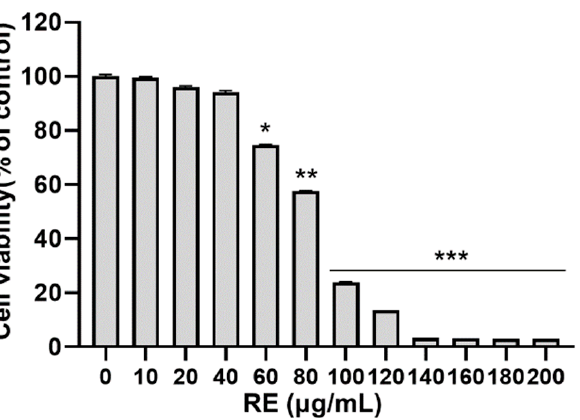
Figure 1. Effects of rosemary extract (RE) on C2C12 myoblast viability. Seeded cells were treated with indicated concentrations of RE for 24 h, and percent cell survival was measured using the MTT assay. Values and error bars indicate means ± SD of three separate experiments. Asterisks indicate significant differences between RE- and vehicle-treated cells (ANOVA; *, p < 0.05; **, p < 0.01; ***, p < 0.001).